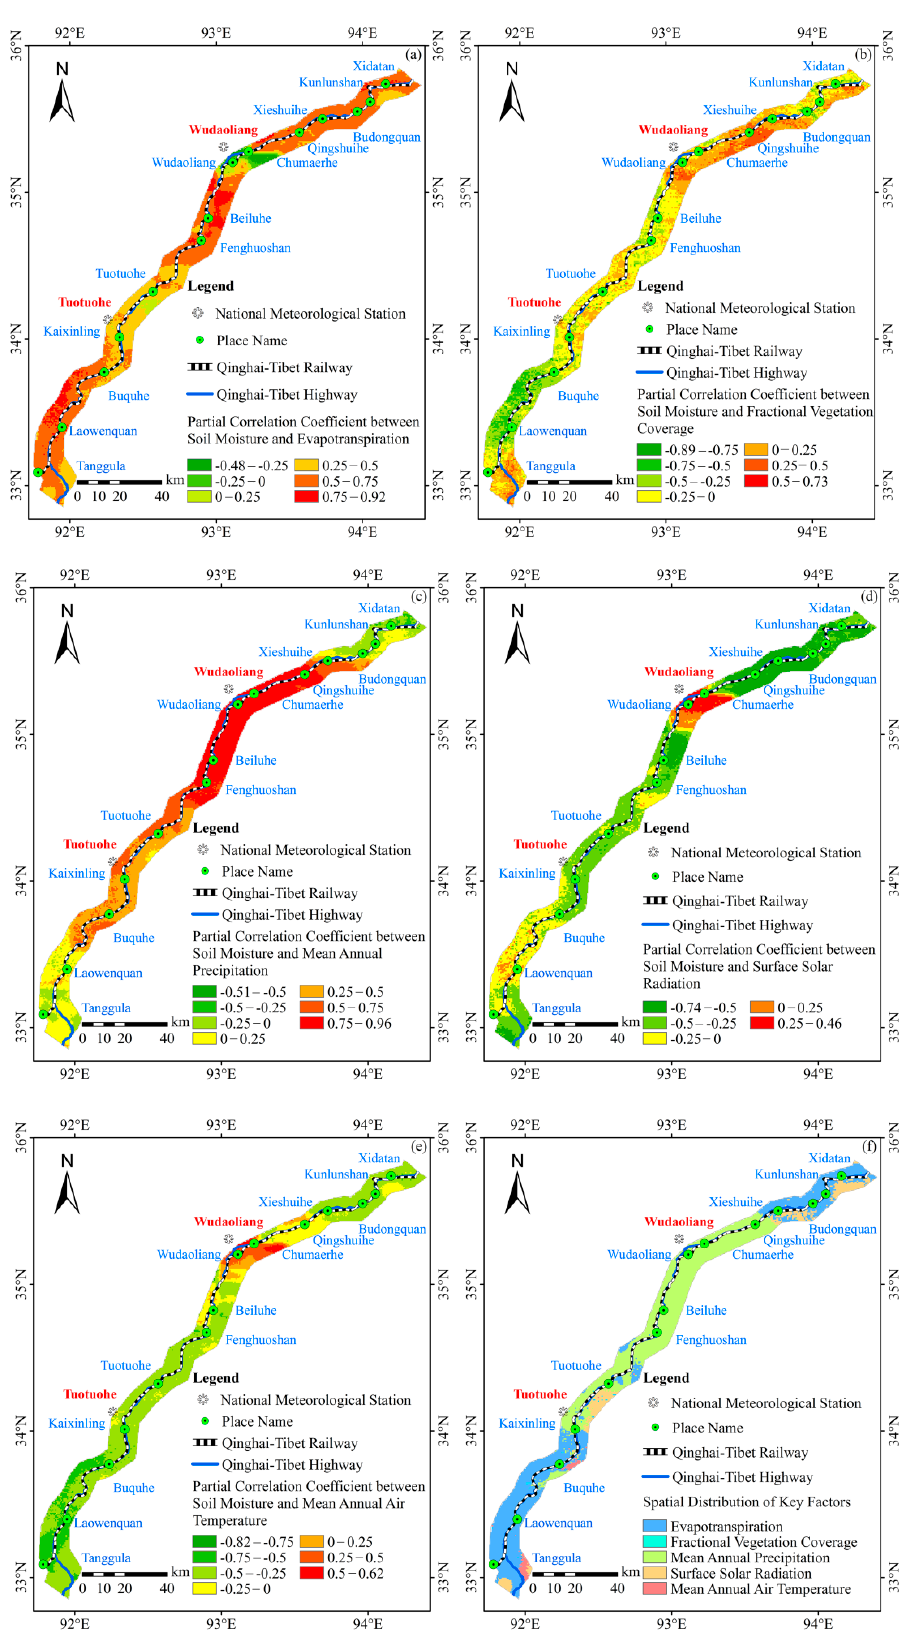
Figure 12. Spatial distribution of the partial correlation coefficient between SM and driving factors, and key factors affecting SM: ( a ) ET; ( b ) FVC; ( c ) MAP; ( d ) SR; ( e ) MAAT; ( f ) key factors. SM, a risk factor of ecological environmental risk, was also affected by other risk fac- tors to varying degrees. Therefore, the factor with the maximum absolute value of the partial correlation coefficient on the pixel was selected as the main risk factor. It can be seen, from Figure 12f, that, in the entire study area, ET, FVC, MAP, SR and MAAT affected 43.30%, 0.31%, 45.67%, 9.04% and 1.67% of the area, respectively. Therefore, the influence degree of each influencing factor on soil moisture in the study area was expressed as MAP > ET > SR > MAAT > FVC, indicating that MAP and ET were the main influencing factors of MAP in the study area from 2003 to 2016. 4.2.4. Driving Factor Analysis of ABC The partial correlation between ABC and ALT, FVC, LST, MAP, SM, SR and MAAT in the study area from 2003 to 2016 was analyzed. The spatial distribution characteristics are shown in Figure 13 and the spatial analysis results are shown in the Supplementary Materials (Table S10).